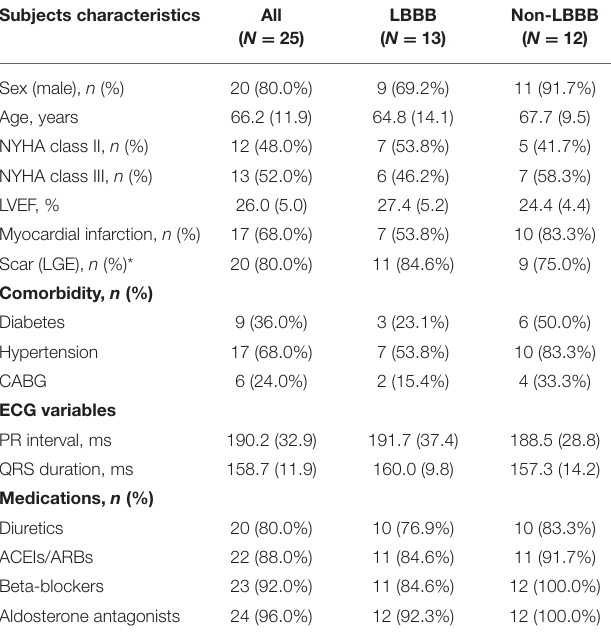
TABLE 2 | Characteristics of the study